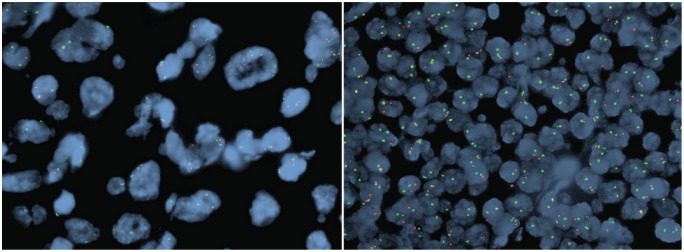
Case 1: clonally related chronic lymphocytic leukemia/small lymphocytic lymphoma (CLL/SLL) and histiocytic sarcoma. Fluorescence in situ hybridization confirms homozygous deletion of 13q14 in the large cells of histiocytic sarcoma (left) and the small cells of CLL/SLL (right). The probes shown here are D13S319 [13q14] (red) and LAMP1 [13q34] (green). Homozygous deletion is represented by 0 red signal and 2 green signals, and heterozygous deletion by 1 red signal and 2 green signals.